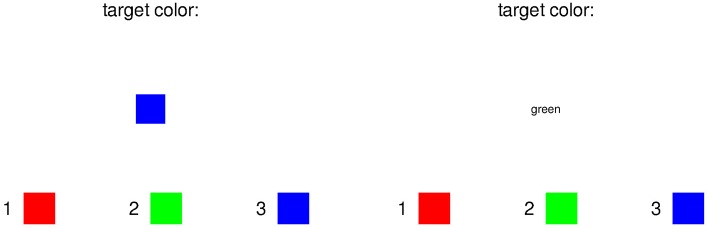
Screen of example 3.